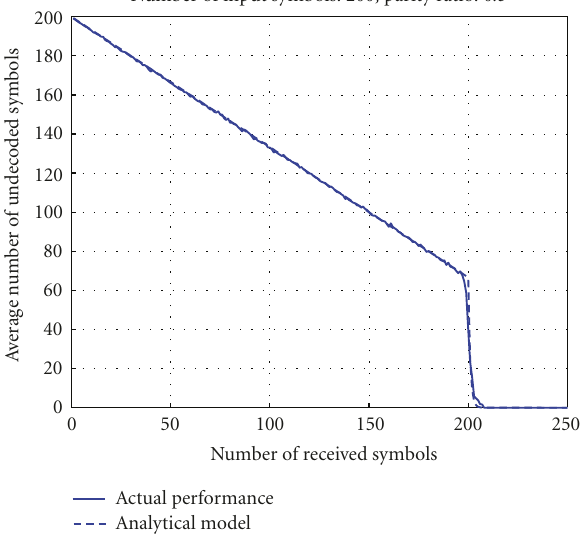
Number of input symbols: 200, parity ratio: 0 . 5